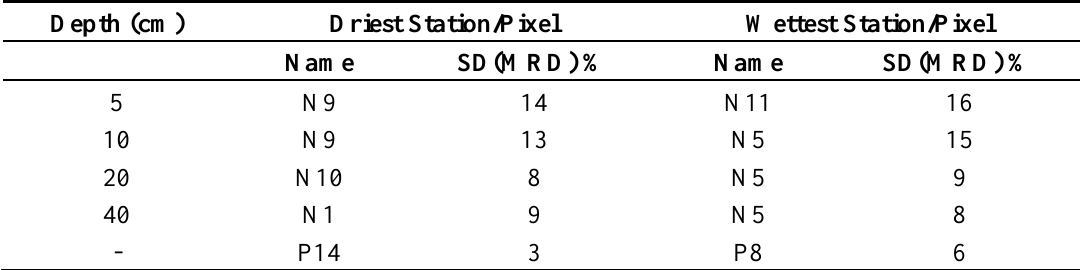
Table 3. SD(MRD) of the driest and the wettest stations/pixels at 5, 10, 20 and 40 cm depth. Depth